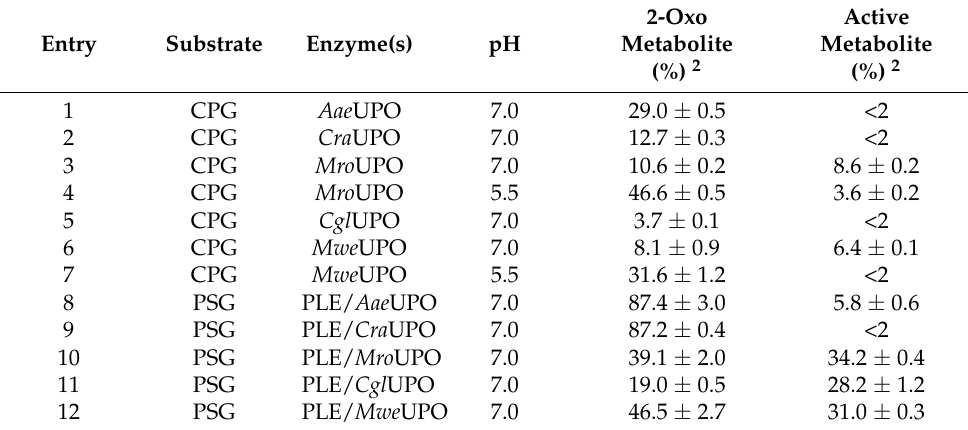
Table 1. Screening of different UPOs for their ability to convert thienopyridines into 2-oxo metabolites and active metabolites 1